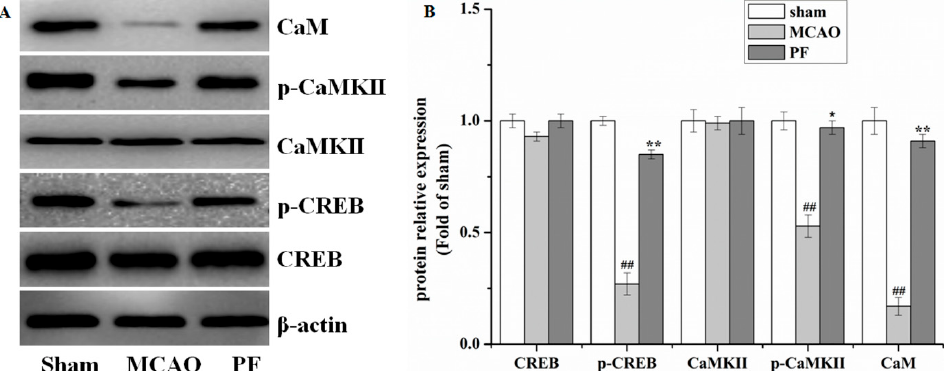
Figure 2. Effects of PF on the expression in the Ca 2+ /Ca 2+ /calmodulin-dependent protein kinase II (CaMKII)/cAMP response element-binding (CREB) signaling pathway in ischemic penumbra after MCAO. ( A ) Western blot and ( B ) the relative optical densities analysis of the level of CaM, CaMKII, p-CaMKII, CREB, p-CREB. β -actin were used as the internal controls. All data were presented as mean ± SD. ## p < 0.01 vs. sham, * p < 0.05 and ** p < 0.01 vs. MCAO.